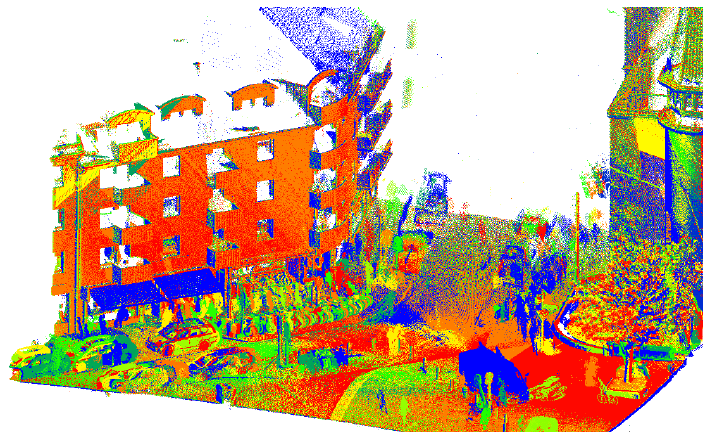
Figure 15. Point cloud from seven measurement campaigns. Points are colored by campaign (blue = oldest, red = most recent).